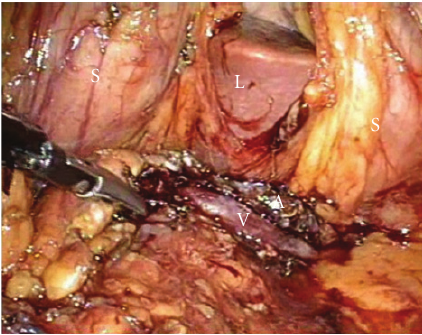
Figure 5: Tumor bed after resection. The splenic vessels (A = splenic artery, V = splenic veins) are seen intact in the horizontal manner.